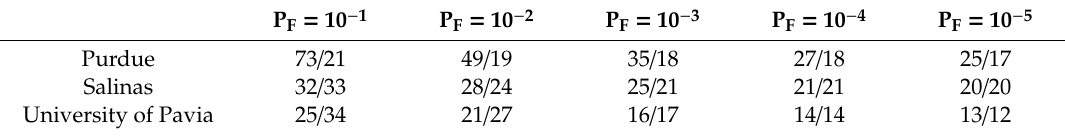
Then, uniform band selection (UBS), variance (V), SNR (S), entropy (E), ID, CBS, and the proposed SBSF and PBSF were implemented to find the desired bands listed in Table